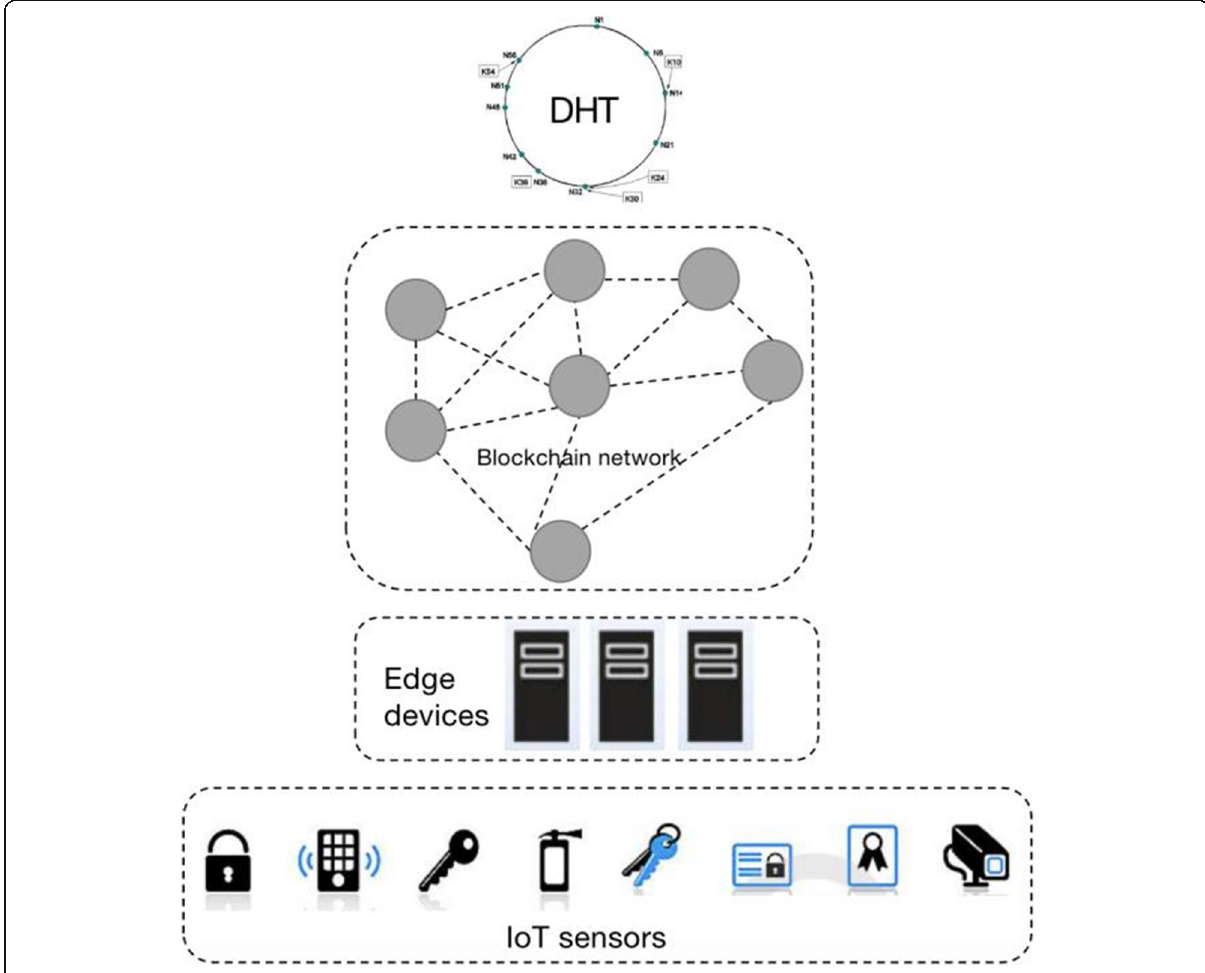
Fig. 16 Four-layered architecture for data management